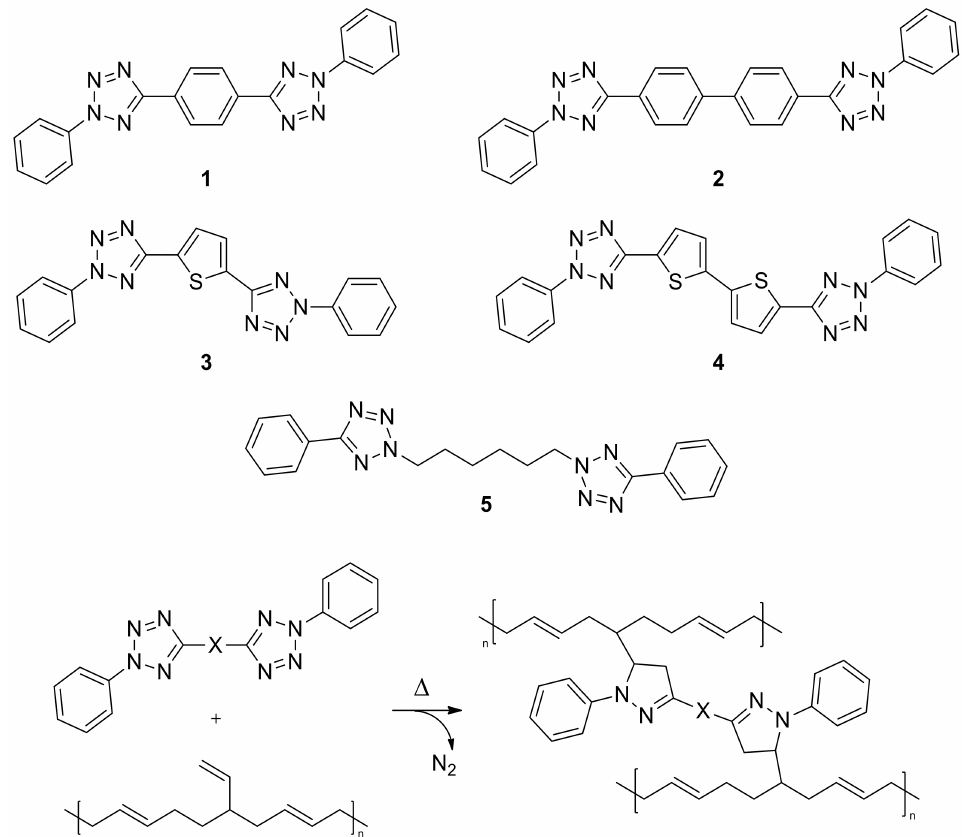
Figure 1. Structures of bistetrazoles 1–5 used in this study and expected reactivity toward poly- meric